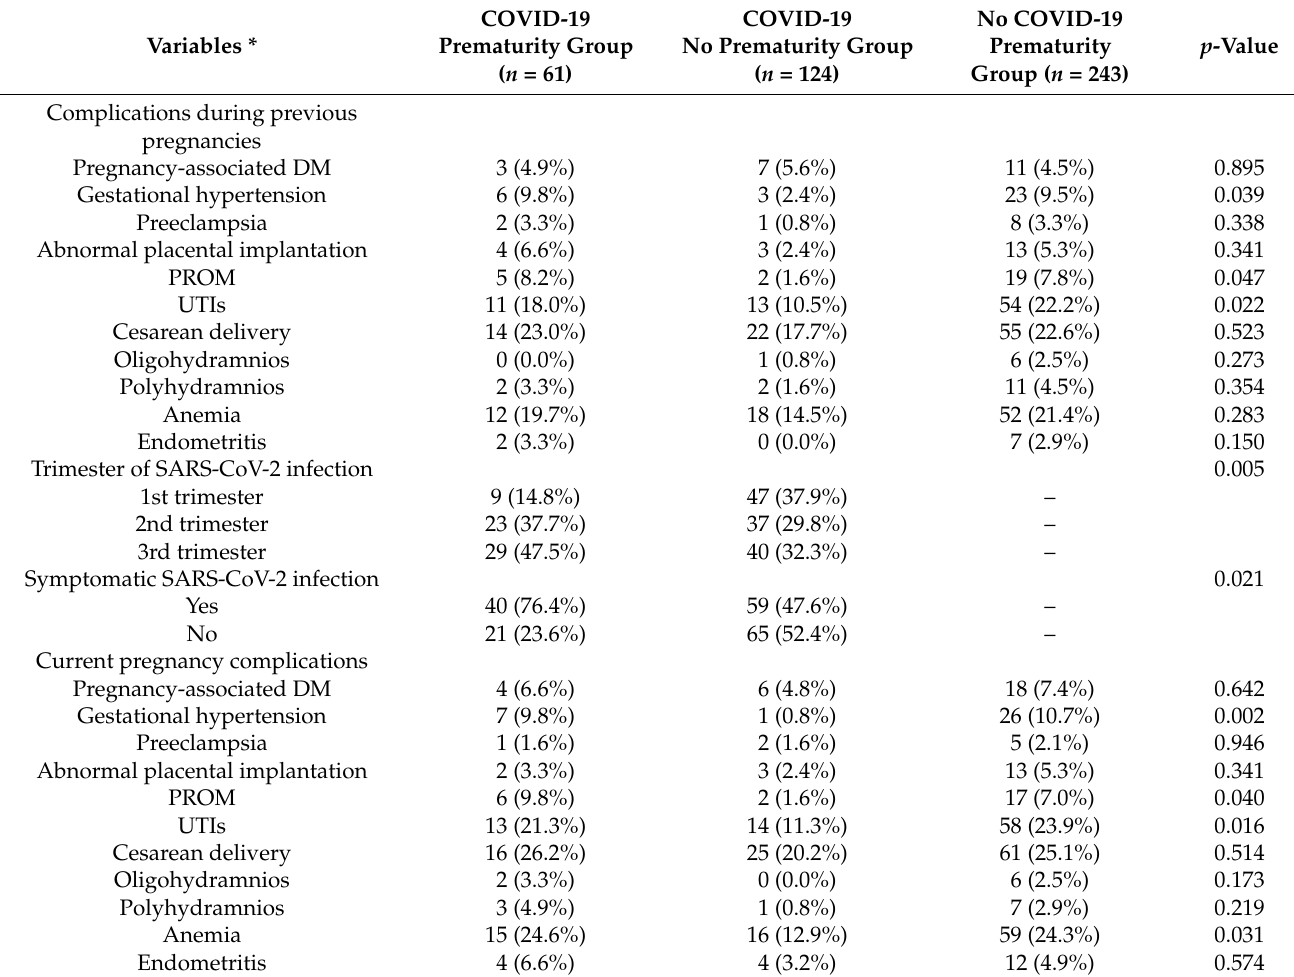
Table 2. Patient outcomes.